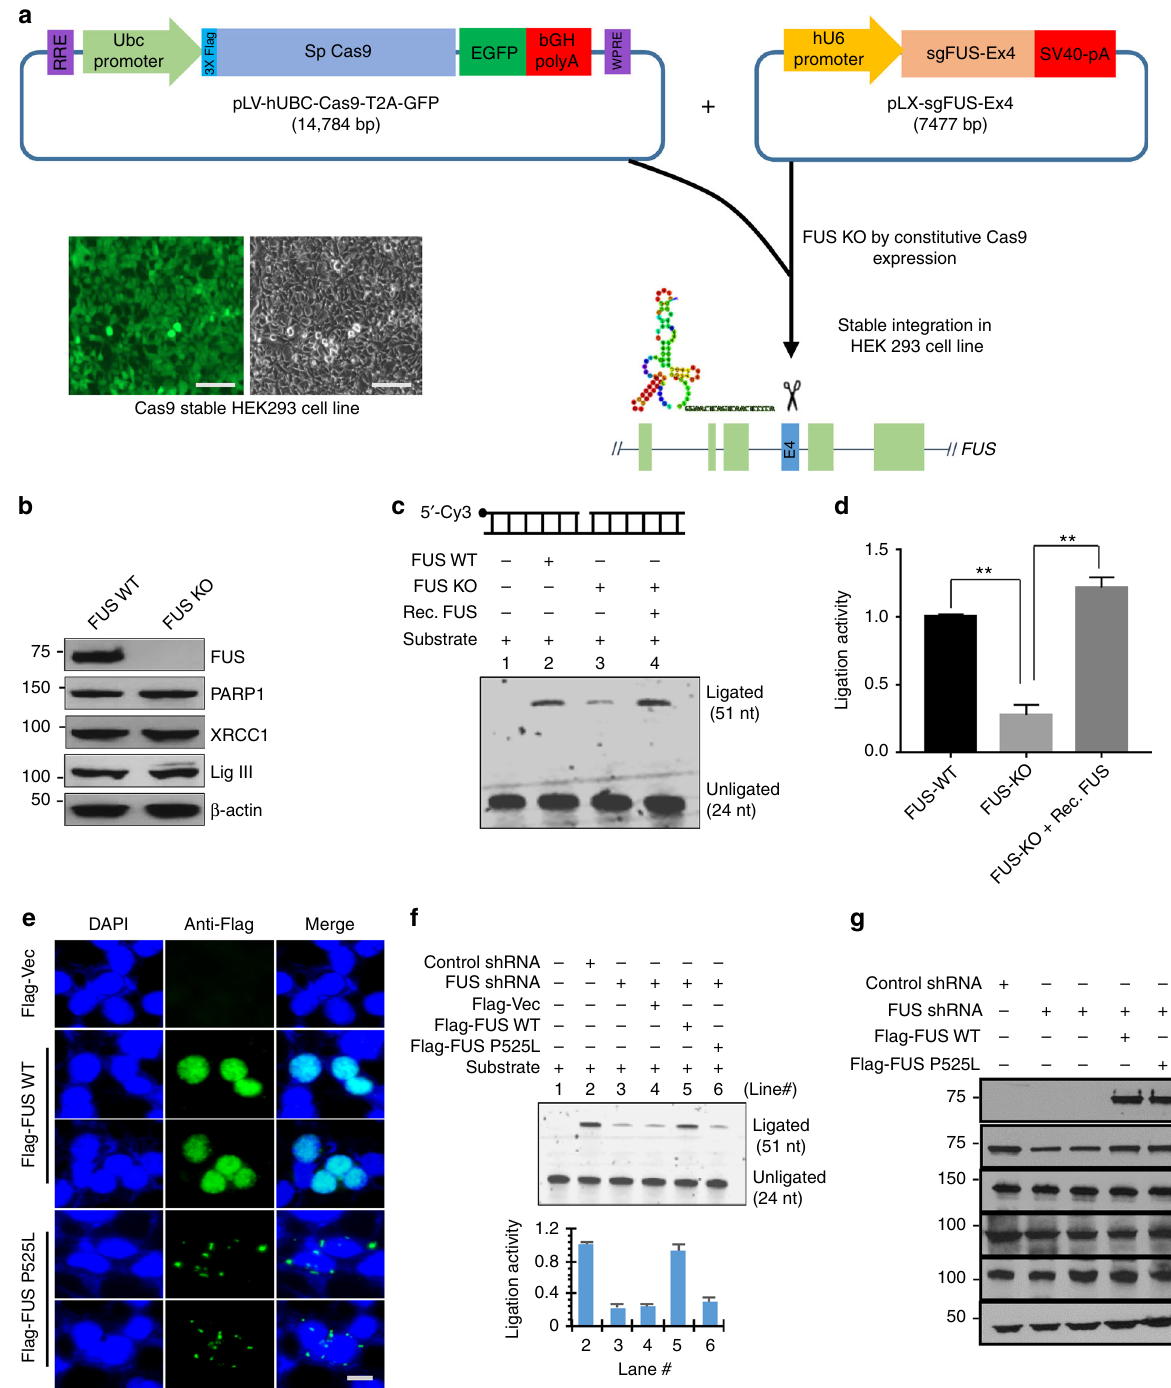
Fig. 4 DNA ligation defects in CRSPR/Cas9-mediated FUS KO cells. a Scheme of CRISPR/Cas9 targeting of FUS. Images indicate stable expression of GFP- Cas9 in HEK293 cells. Scale bar = 50 µ m. b IB of endogenous FUS, PARP1, XRCC1 and LigIII in FUS WT and FUS KO HEK293 cells. β -actin was probed as loading control. c, d In vitro DNA nick ligation activity assay. XRCC1 IP complex from nuclear extract of GO-treated FUS WT and FUS KO HEK293 cells, was incubated with or without puri fi ed FUS. d Quantitation of ligation activity (** p < 0.01, two-tailed unpaired Student ’ s t -test). e IF of ectopically expressed Flag-FUS WT and Flag-FUS P525L mutant in HEK293 cells. Endogenous FUS depleted using UTR-speci fi c shRNA. IF was performed by anti-Flag antibody 48 h after the co-transfection of FUS shRNA with either Flag-FUS WT or Flag-FUS P525L plasmid. DAPI staining indicates nucleus. Scale bar = 5 µ m. f In vitro DNA nick ligation assay. Rescue of DNA ligation defect in FUS KD HEK293 cells by WT vs P525L mutant FUS expression. XRCC1 IP complex from nuclear extract of GO-treated FUS KD HEK293 cells with or without ectopic FUS WT and FUS P525L expression. The quantitation of ligation activity is shown in the histogram (bottom). g IB of cell extract used in f to con fi rm the comparable level of PARP1, XRCC1, and LigIII in WT or mutant FUS expressing cells. β -actin was probed as loading control. All error bars are standard deviation of experiments performed in